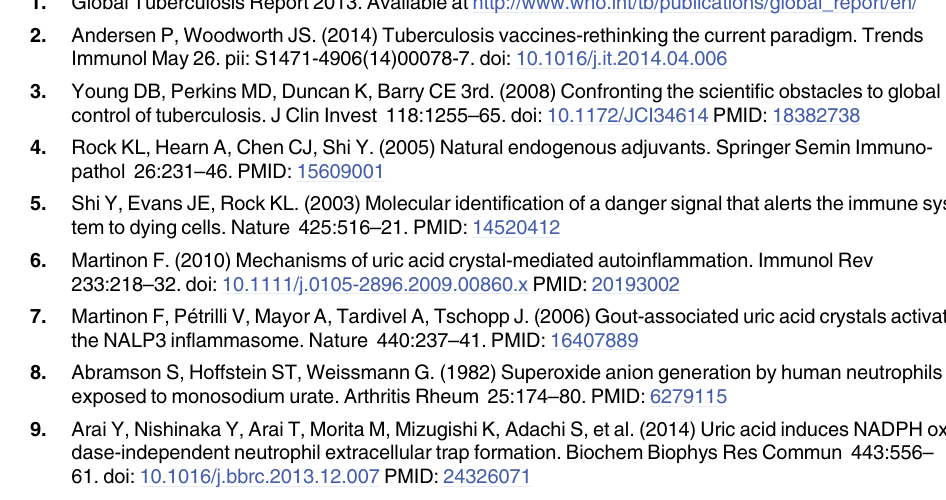
S2 Fig. Evaluation of BCG stability following formulation with MSU. BCG was suspended in 200 μ l PBS in the presence or absence of 200 μ g MSU crystals in order to mimic BCG formu- lation which was administrated in mice. Mycobacterial viability was monitored by CFU assay at 24 and 48 hours incubation at 37°C. Data are expressed as mean ± S.D. of CFU values per- formed in triplicate. n.s. = not significant in comparison with control